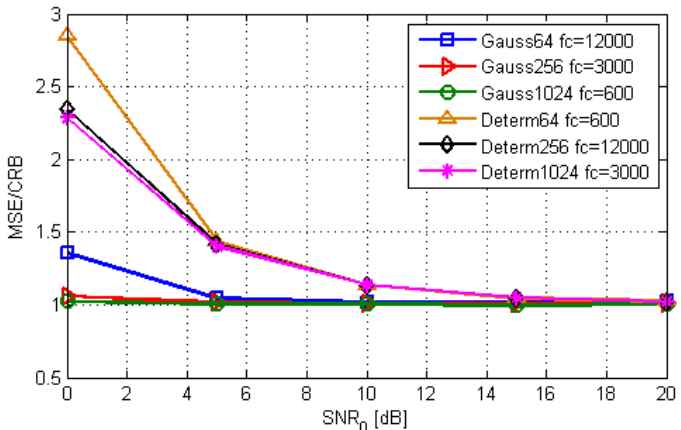
Figure 11. Statistical efficiency of the ML-US as a function of SNR 0 .